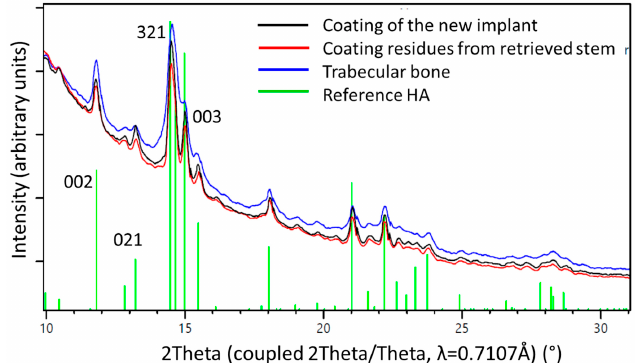
Figure 8. 1D diffraction patterns obtained by a 360° integration of the 2D diffraction patterns (Figure 6). The indexing of the HA phase is shown in green. The peaks of the coating material from a pristine stem (black line) are higher and sharper than those from the materials residue recovered from the retrieved stem (red line) where the HA already was altered by biodegradation. The blue line marks results from bone trabeculae chipped of the retrieved stem. The observed peak broadening on the trabecular bone sample could be related to nano-sized crystallites and/or better nano-ordering due to strain probably formed during the growth process. Note the higher background signal from the bone sample, due to amorphous materials and proteins present within the tissue.